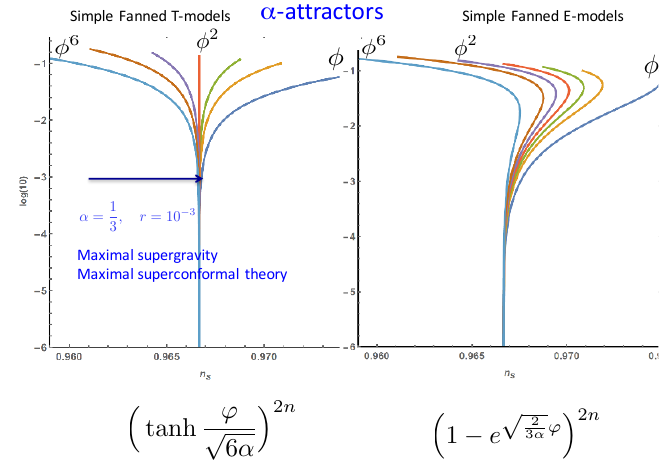
Figure 3 . (cid:11) -attractor models in n